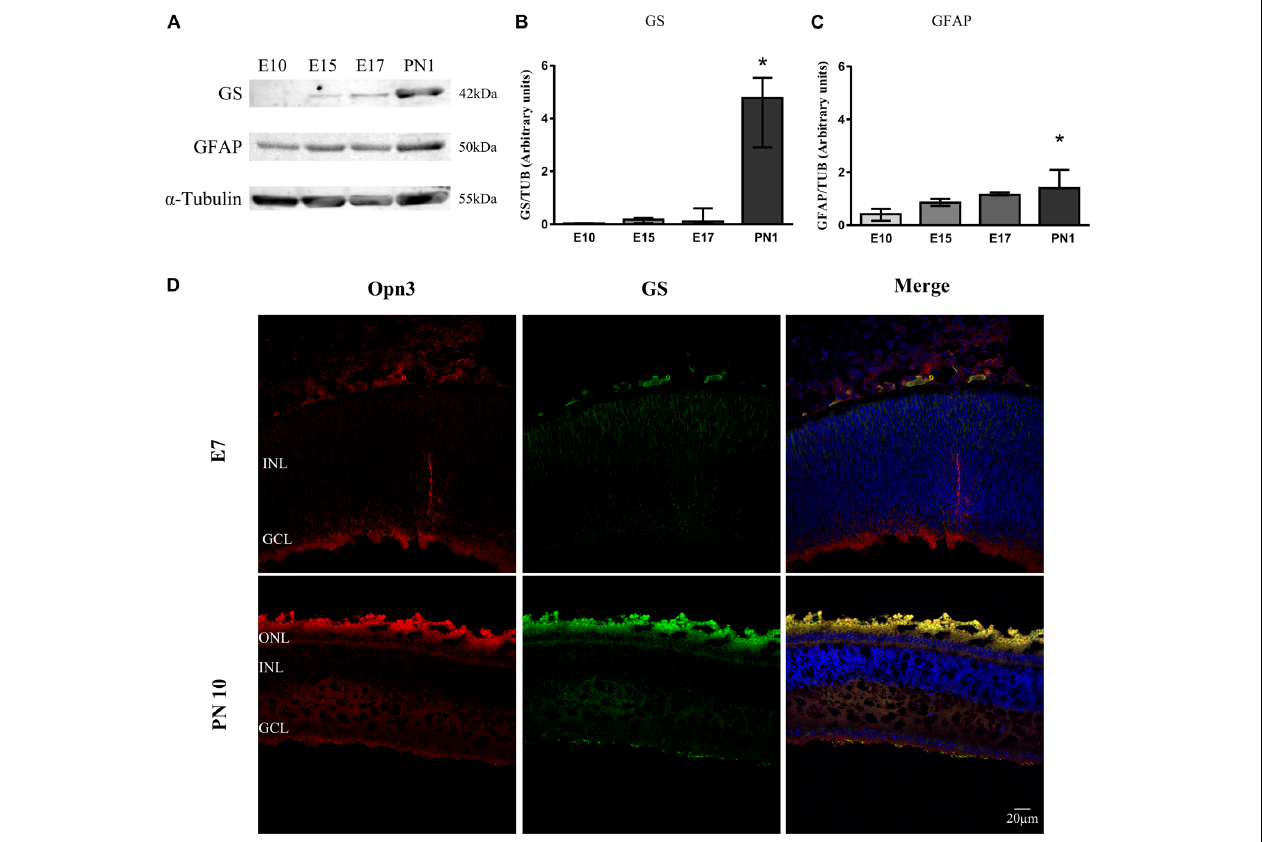
FIGURE 2 | Temporal profile of Müller glial cells markers in the developing chicken retina. (A) Analysis of glutamine synthetase (GS) and glial fibrillary acidic protein (GFAP) levels of whole chicken retinas from embryonic day 10 (E10) to post-natal day 1 (PN1) assessed by WB; immunoblots show bands at ∼ 42 and 50 kDa, respectively. (B,C) The histograms show the median with range of GS and GFAP levels in the whole chicken retina from E10 to PN1. The K–W test revealed a significant effect of development on glial markers’ protein expression [ H ( 3 ) = 9.36, p < 0.001 for GS and H ( 3 ) = 10.38, p < 0.0001 for GFAP]. PN1 values differ from those at E10 stage ( ∗ p < 0.05, n = 3/group). (D) Immunohistochemistry showing co-localization of Opn3- (red) and GS-like proteins (green) in the chicken retina at E7 and PN10. At E7 Opn3-like protein is localized mainly in the ganglion cell layer (GCL) with low GS expression. In the PN10 stage, Opn3-like protein shows a